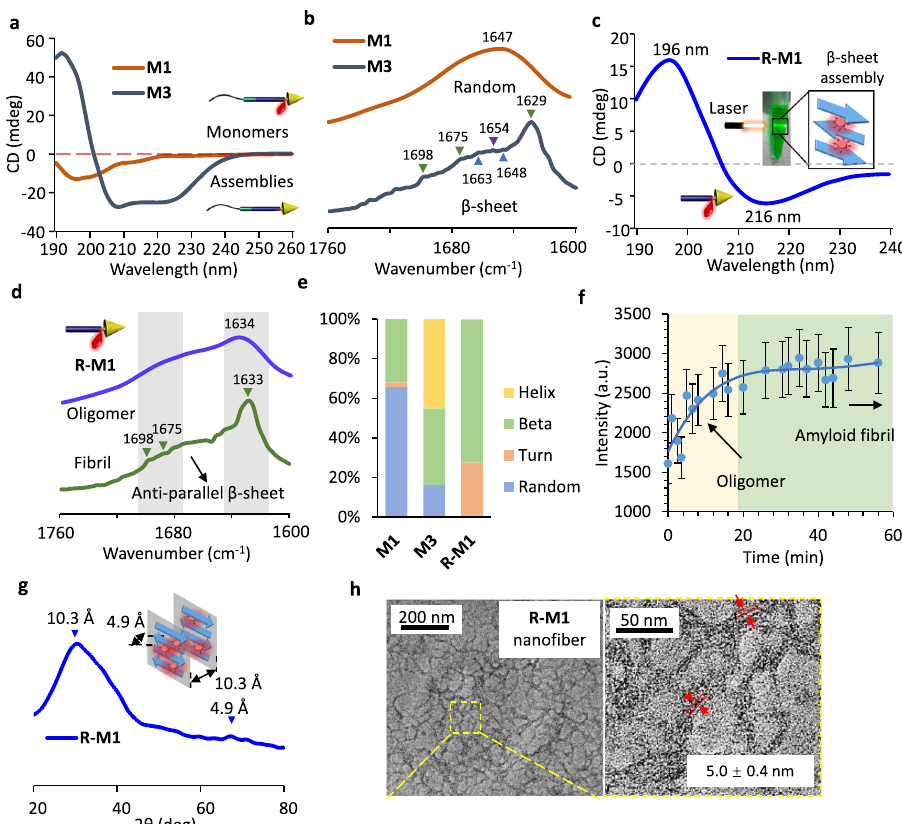
Fig. 3 Assembled structure conformations and self-assembly behavior in aqueous solution. a CD spectra of M1 and M3 in DI water under a concentration of 200 μ M. b The FTIR spectra of M1 and M3 , powder samples collected from freeze dried sample solutions. c The typical β -sheet CD spectra of R-M1 in DI water (insert fi gure: the Tyndall phenomenon) under a concentration of 100 μ M. d The FTIR spectra of dynamic growth of R-M1 , powder samples collected from freeze dried sample solutions in different period. e Analysis of secondary structure composition of M1 , M3 , and R-M1 based on CD spectra. f , Elongation-nucleation growth procedure with ThT staining. The mean of data of three samples with the same conditions is shown and data are presented as mean values± SD ( n = 3) g , The WAXS spectrum and illustration of the R-M1 fi brils, powder sample collected from freeze dried sample solution. h , The TEM images of nano fi bers morphology of R-M1